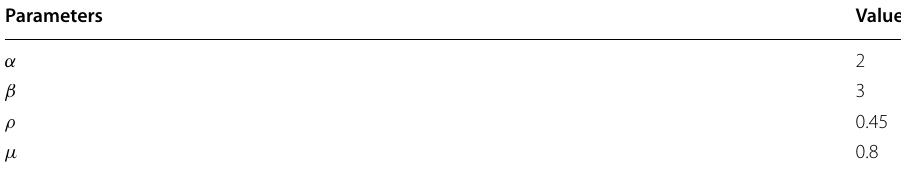
Table 1 Parameters in enhanced ACO algorithm